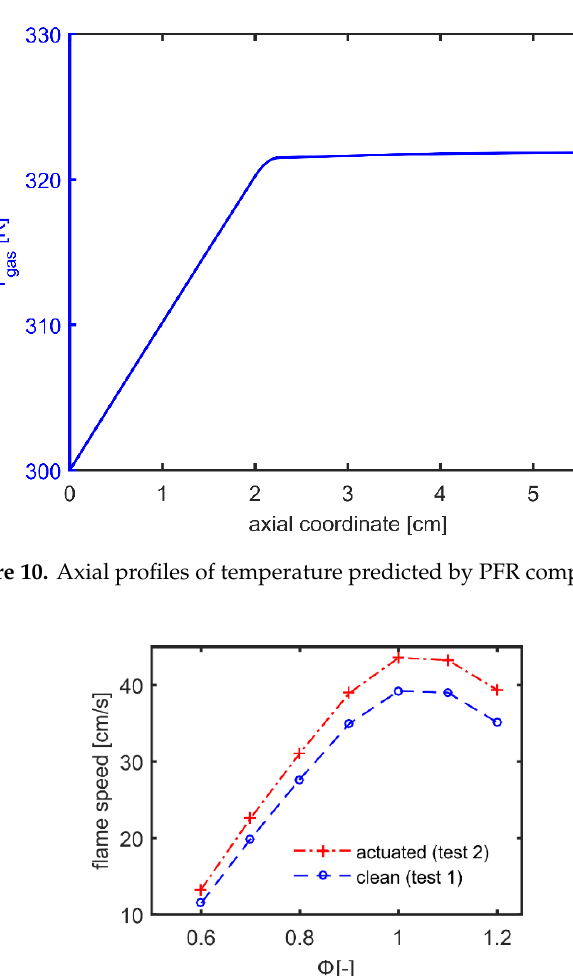
Figure 11. Numerical prediction of the flame speed as a function of the local equivalence ratio Φ .